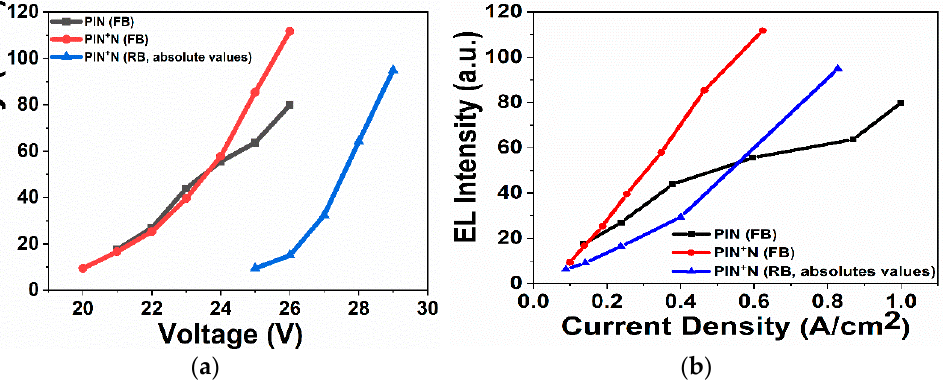
Figure 5. ( a ) PIN + N device of 1 mm 2 emitting red light, ( b ) enlarged image of the same PIN + N device.